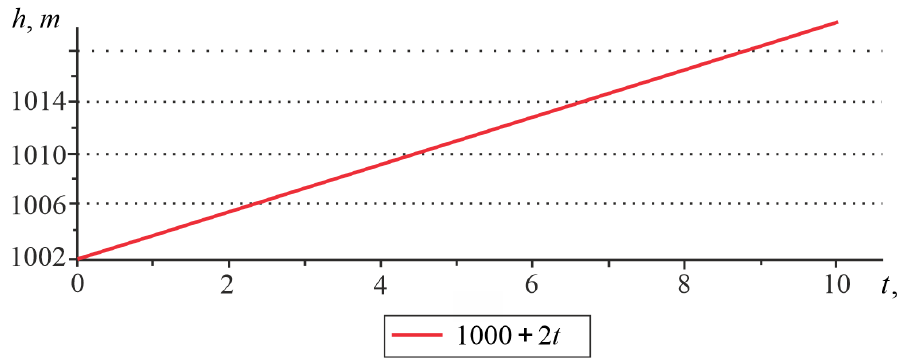
Figure 11. Height estimation (second simulation).